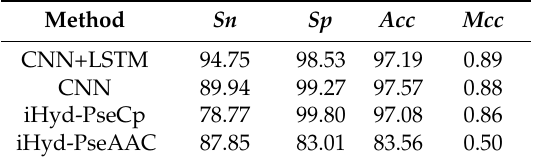
Table 6. A comparison of predictors for identifying hydroxylysine sites on Dataset